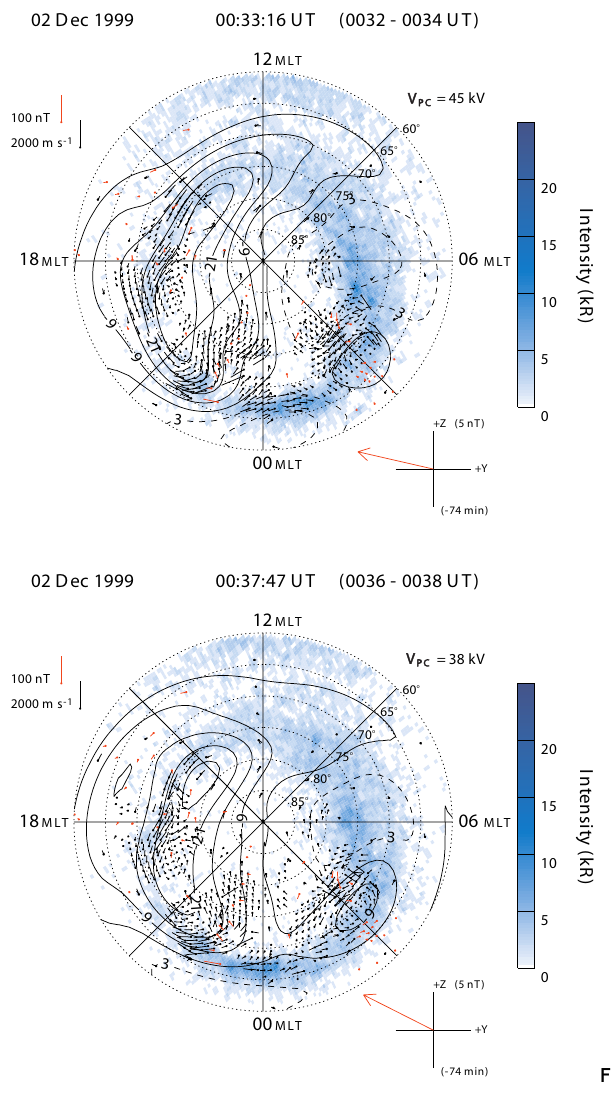
Fig. 7. Maps of the UV auroral lu- minosity projected onto a geomagnetic grid are shown spanning the same in- terval as in Fig. 6. SuperDARN Map- Potential streamlines and flow vectors are superposed. Magnetic data, shown in red, are horizontal magnetic pertur- bation vectors which have been rotated anti-clockwise through 90 ◦ to point in the direction of the E × B drift, as- suming they are due wholly to over- head Hall currents. Also indicated on the maps is the derived total transpolar voltage and the direction and magnitude (in the Y − Z plane) of the IMF, as in Fig. 6. The time indicated on each plot corresponds to the center time of the 32.5s integration interval of the UV im- age. The superposed SuperDARN and 2-min averaged magnetic vectors corre- spond to the interval shown in brackets, which encompasses the center time of Fig. 7a the UV